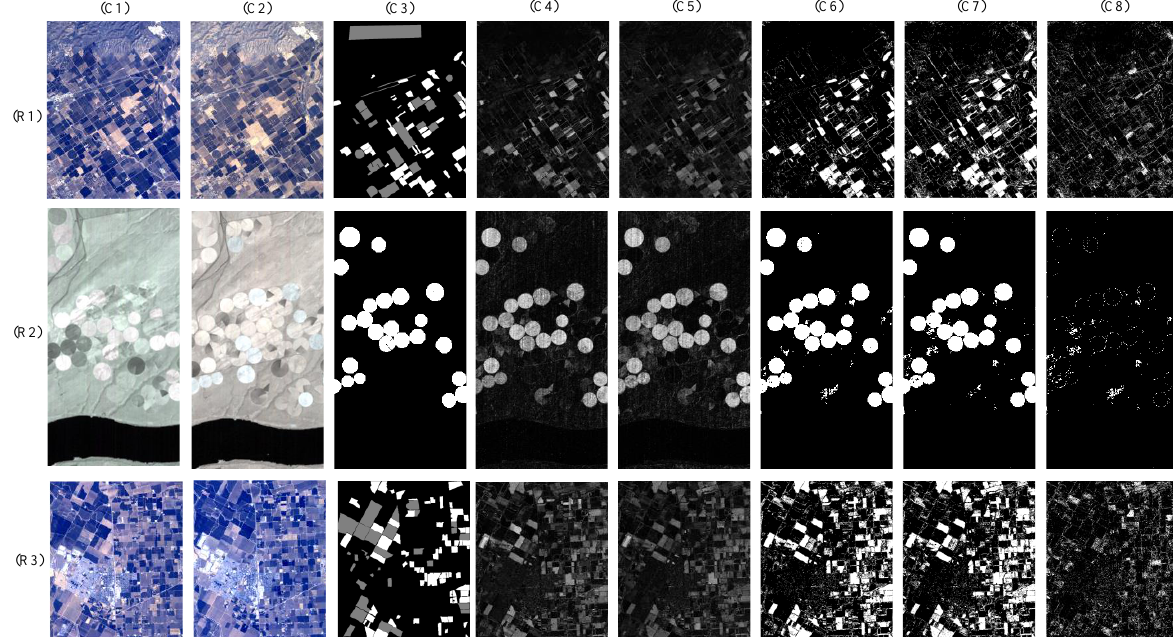
Figure 6. Tested scene images and the corresponding results in the process. ( R1 ) ‘Santa Barbara’, ( R2 ) ‘Hermiston’, and ( R3 ) ‘Bay Area’. ( C1 ) Reference image, ( C2 ) Query image, ( C3 ) Ground truth map, ( C4 ) USNet-CPM, ( C5 ) CSNet-CPM, ( C6 ) USNet-BCM, ( C7 ) CSNet-BCM, and ( C8 ) Argument region.